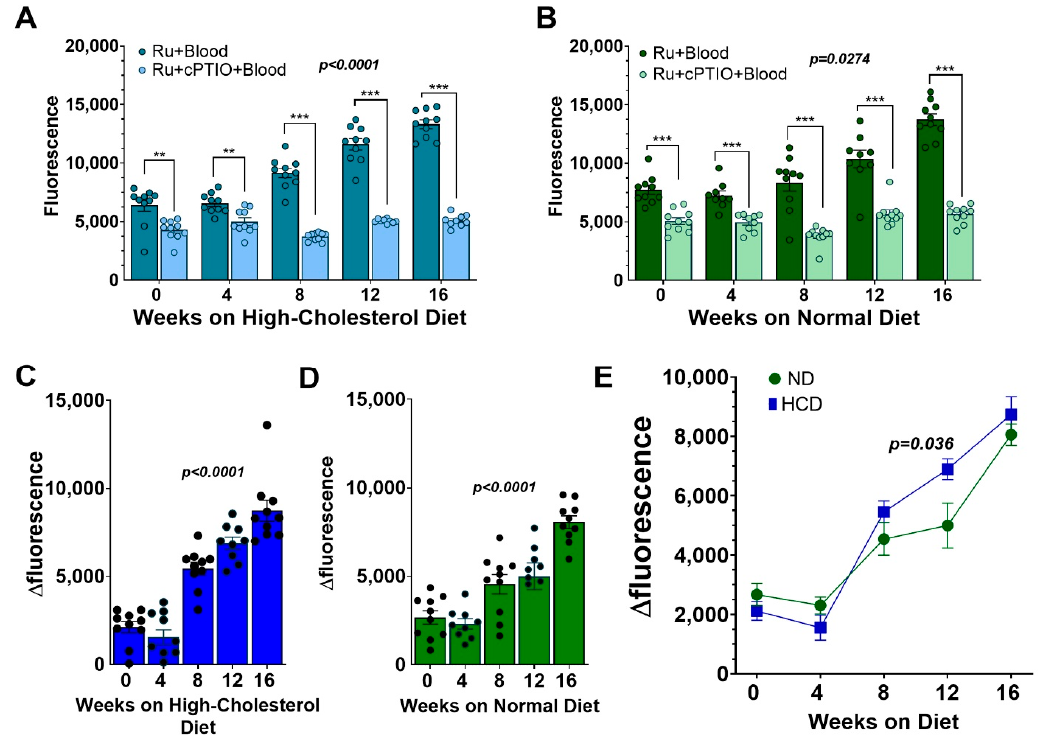
Figure 6. Plasma Ru-NO fluorescence is higher in mice after 12 weeks of high-cholesterol diet than with chow feeding. Spectrophotometric readings of Ru-NO fluorescence in plasma from blood samples collected every four weeks added with Ru-NO or Ru-NO + cPTIO (NO scavenger) in mice fed ( A ) high-cholesterol diet (HCD) and ( B ) chow for 16 weeks. Δ fluorescence (Ru-NO–Ru-NO + cPTIO) specific NO signal in plasma from mice fed ( C ) HCD and ( D ) chow with ( E ): combined analyses directly comparing the signal between HCD- and chow-fed mice. Mean ± SEM, ** p < 0.01 and *** p < 0.001 using two-way ANOVA with Tukey post-hoc test for multiple comparisons across different groups. The p values in ( A – D ) for the linear trend were also calculated (n = 9–10 mice/group).